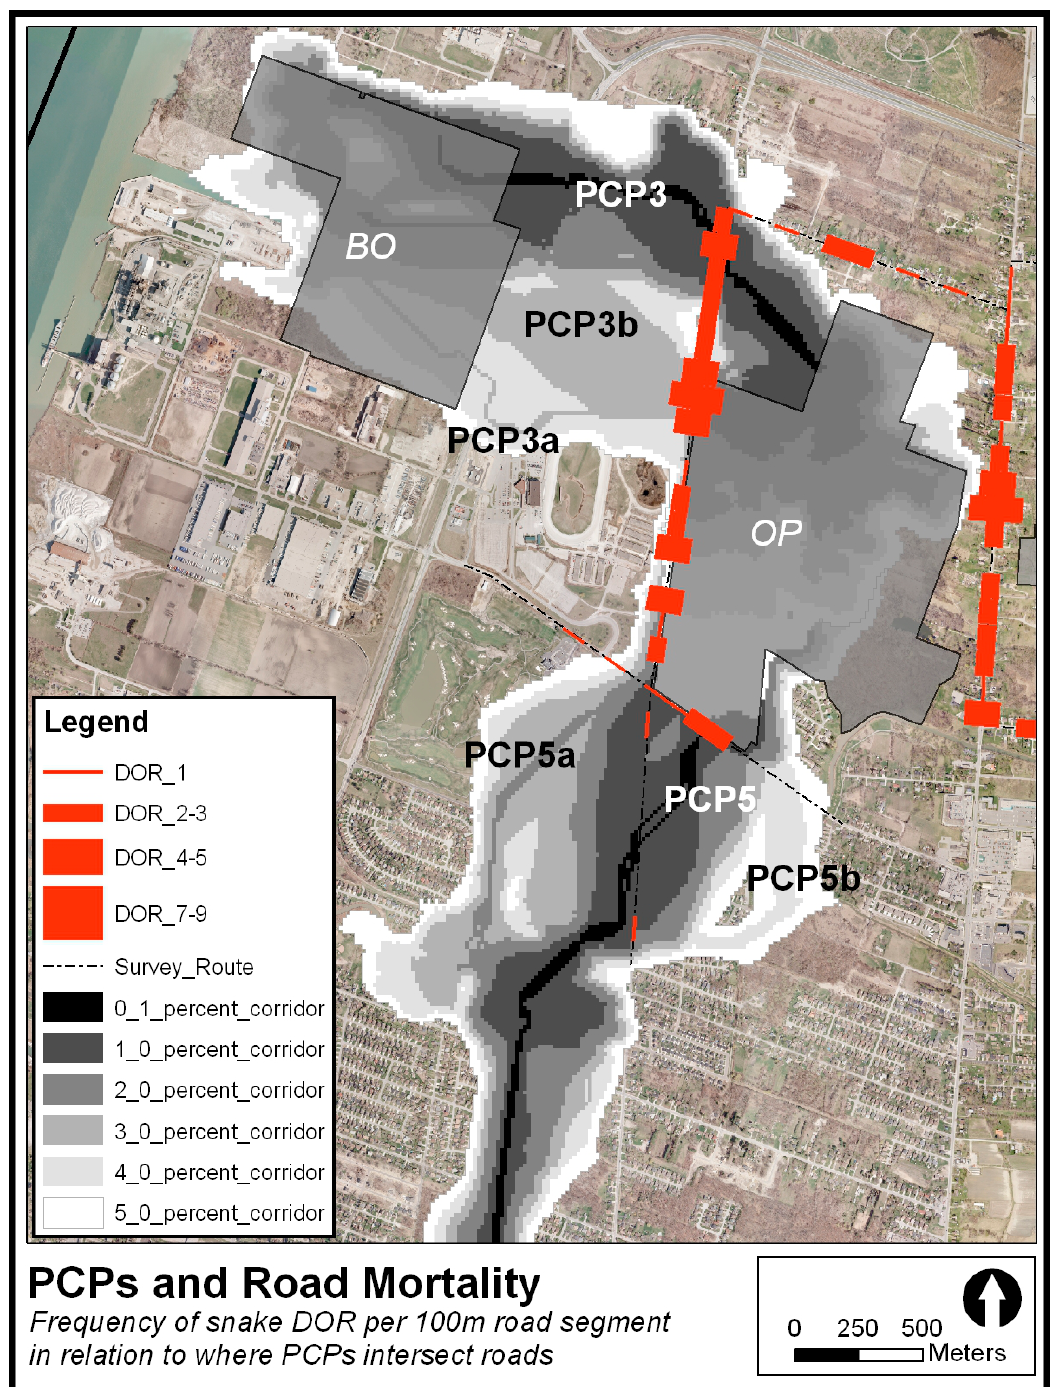
Figure 11. Overlay of snake road mortality frequency per 100 m road segment on potential connectivity pathways (PCP) between Black Oak Heritage Park (BO), Ojibway Prairie (OP) and Marentette Drain Woodlots (MC).